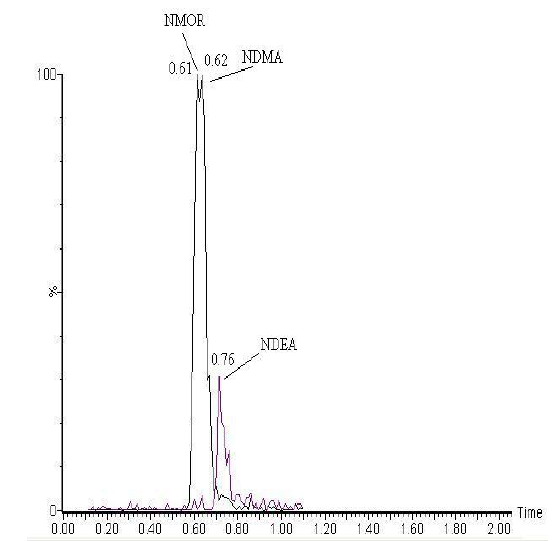
Figure 4. UHPLC-(ESI+)-MS/MS chromatogram obtained from the analysis of standard mixture of N-nitrosamines at 5 µg L -1 (only quantification transition is shown for each N-nitrosamine), retention time (min), and peak area (arbitrary